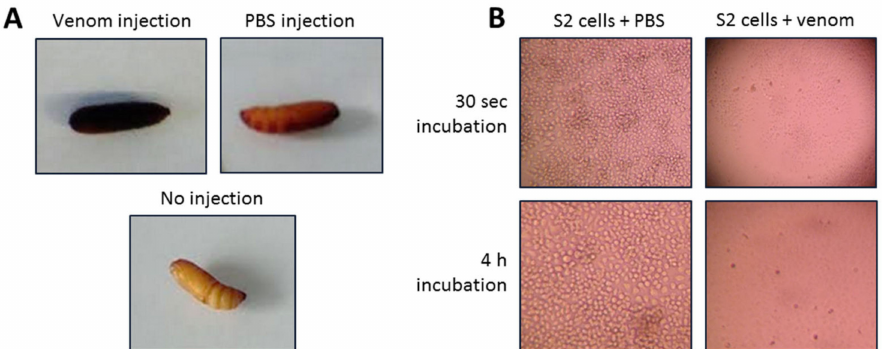
Figure 5. Effect of assassin bug Rhynocoris iracundus venom on insects. ( A ) Melanization of G. mellonella pupae in response to R. iracundus venom injection was assessed 4 h post injection. PBS injected and no injected pupae were used as controls. ( B ) Effect of venom on S2 cells after 30 s of co-incubation with venom. Morphological changes of S2 cells were monitored using an inverted microscope. Incubation of S2 cells together with 174 µ g/mL venom for 30 s caused complete cell lysis. Incubation of S2 cells with PBS only (control) did not cause any visible cell